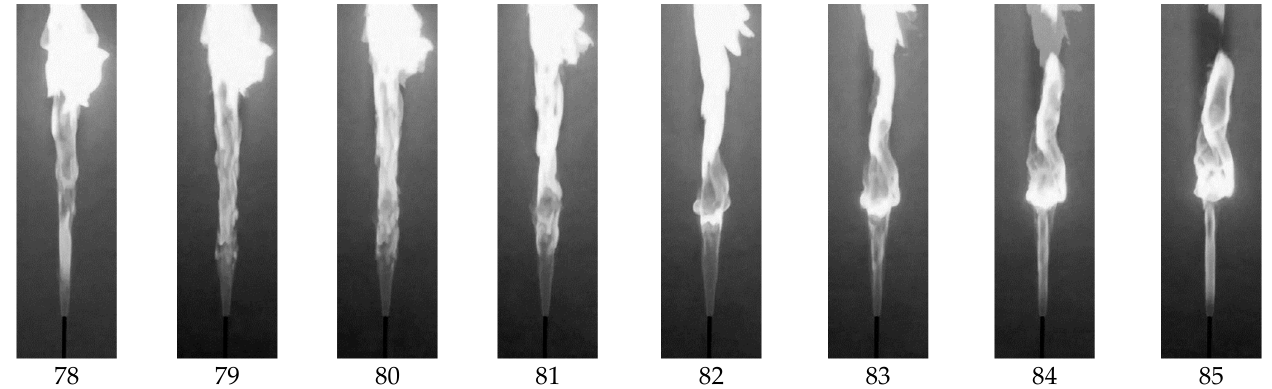
Figure 10. Sequence of video frames (480 fps) of vortex disturbance in the methane-air flame. Frame numbers 78–85, Re = 2312, d = 3 mm (see Supplementary